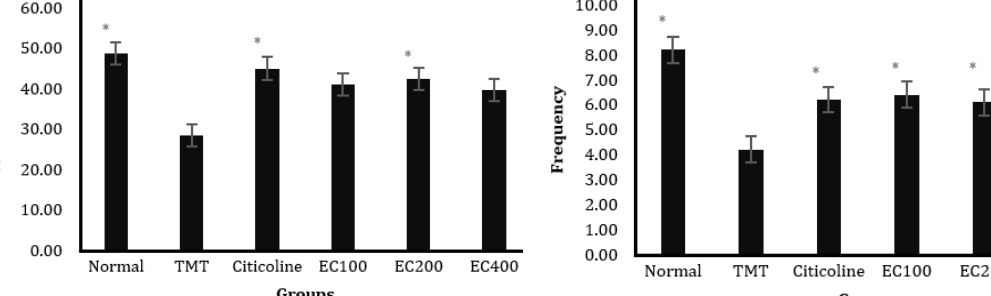
Figure 3. The mean percentage (%) of the time spent in the target quadrant (duration) during the MWM probe trial in all treatment groups. *p<0.05, compared to the TMT group.